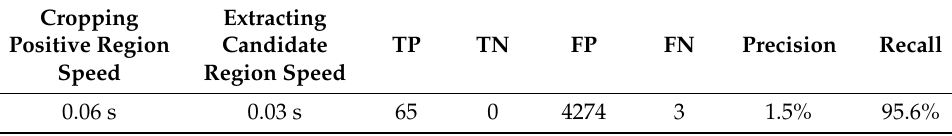
Table 2. Candidate region extraction performance of RT-SPeeDet.